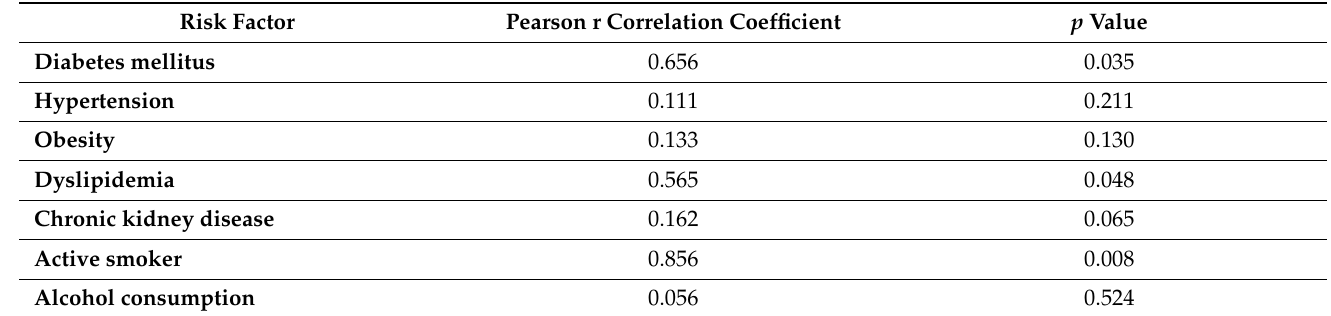
Table 4. Correlations between the presence of cardiovascular risk factors and the severity of coronary lesions in COVID-19-positive